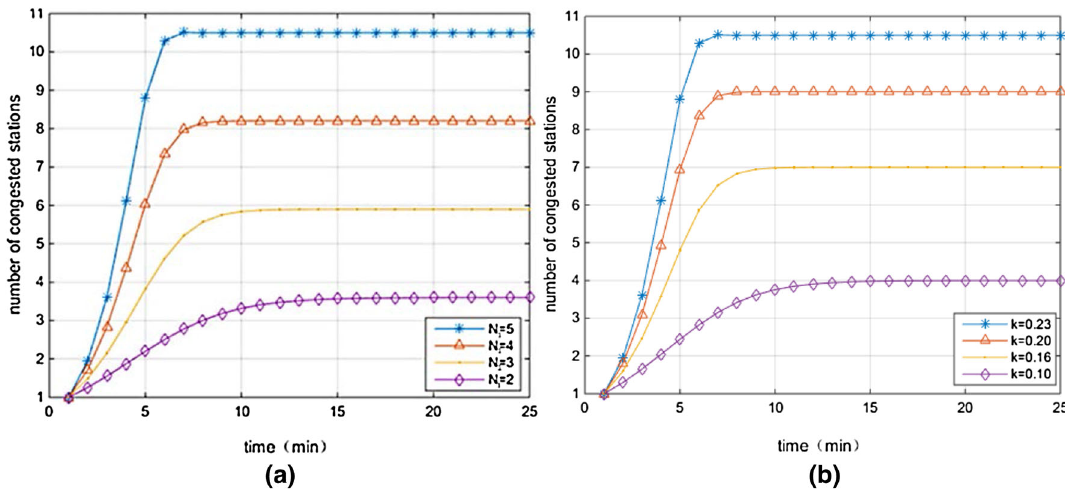
Fig. 5 Congestion propagation simulation under different values of